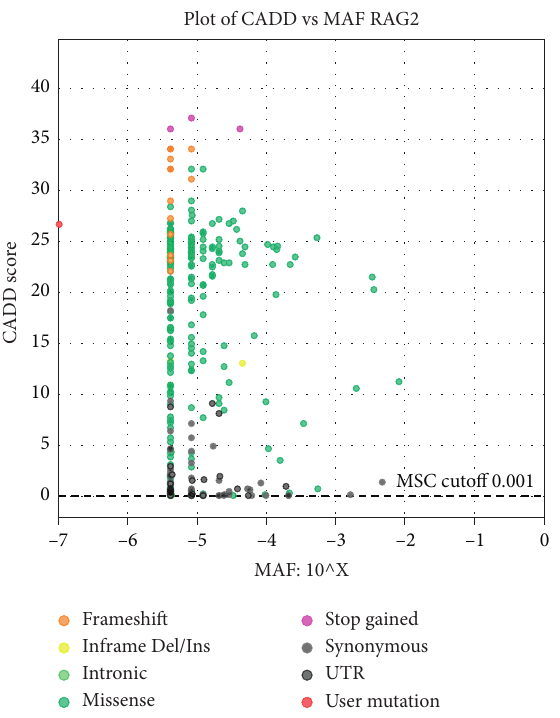
Figure 2: CADD vs. MAF plot of RAG2 by PopViz. The vertical and horizontal axes show the combined annotation-dependent depletion (CADD) and the minor allele frequency (MAF) scores, respectively. The red dot is the c.826G > A variant and the other dots are the other variants for pathogenic RAG2 mutations (frameshift mutations, inframe Del/Ins mutations, intronic mu- tation, missense mutations, etc.) reported. The MAF score is − 7 and the CADD score is 26.6, which indicates that the new mutation c.826G > A is probably